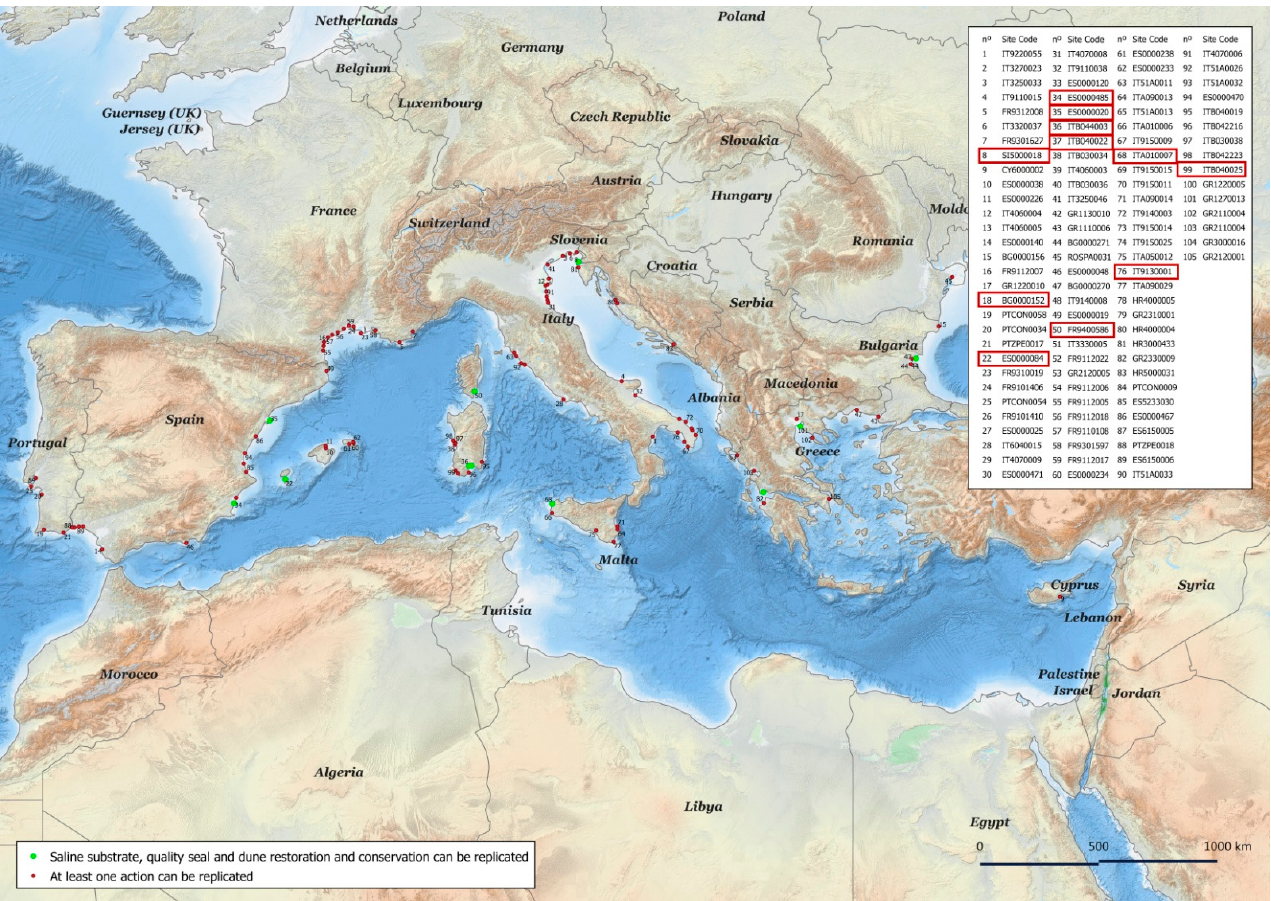
Figure 3. Sites of the Natura 2000 network and location of the 11 sites where the hillocks repair actions with a saline substrate, quality sealing and dune restoration, and conservation can be replicated. The boxed codes correspond to the 11 most favourable replicability sites. Source: own elaboration.